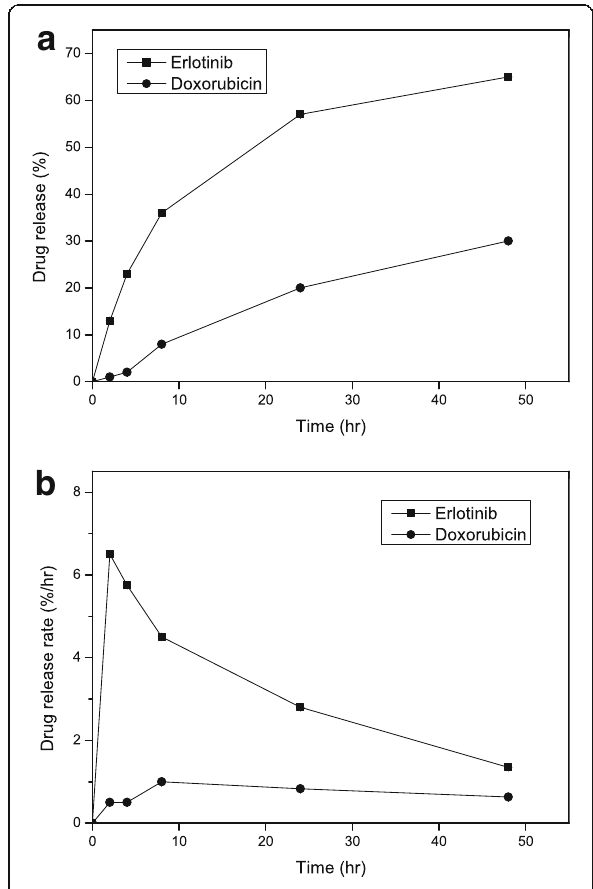
Fig. 8 In vitro release profiles of ERL and DOX from dual drug- encapsulated nanoliposomes: time-differential release ( a ) and release rates of ERL and DOX ( b ) ( n = 3, the data are presented as mean ±